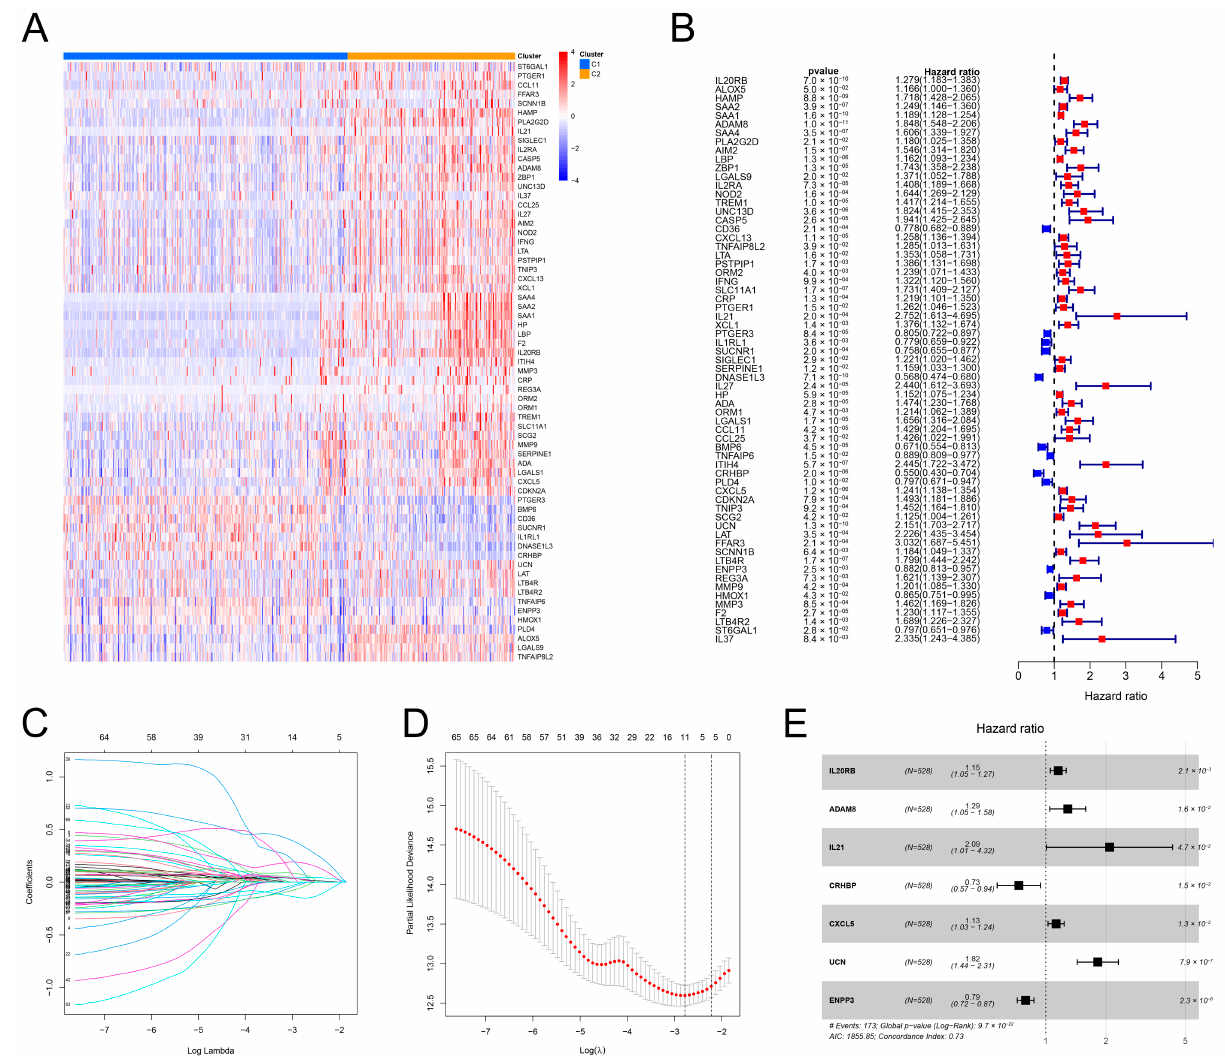
Figure 4. Development of an IRRS. ( A ) Heatmap of inflammation-related DEGs between the two inflammation clusters. ( B ) Outcomes of the univariate Cox regression analysis of inflammation- related DEGs. ( C , D ) Lambda. min value = 11 was determined through LASSO regression analysis. ( E ) Outcomes of multivariate Cox regression